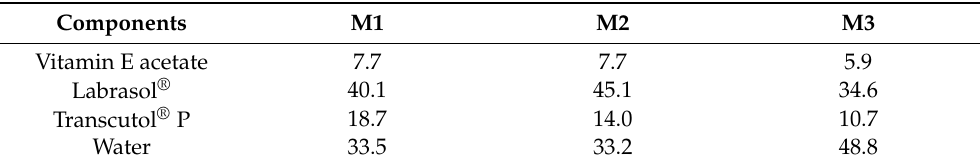
Table 1. Components (% w / w ) of the selected microemulsions.